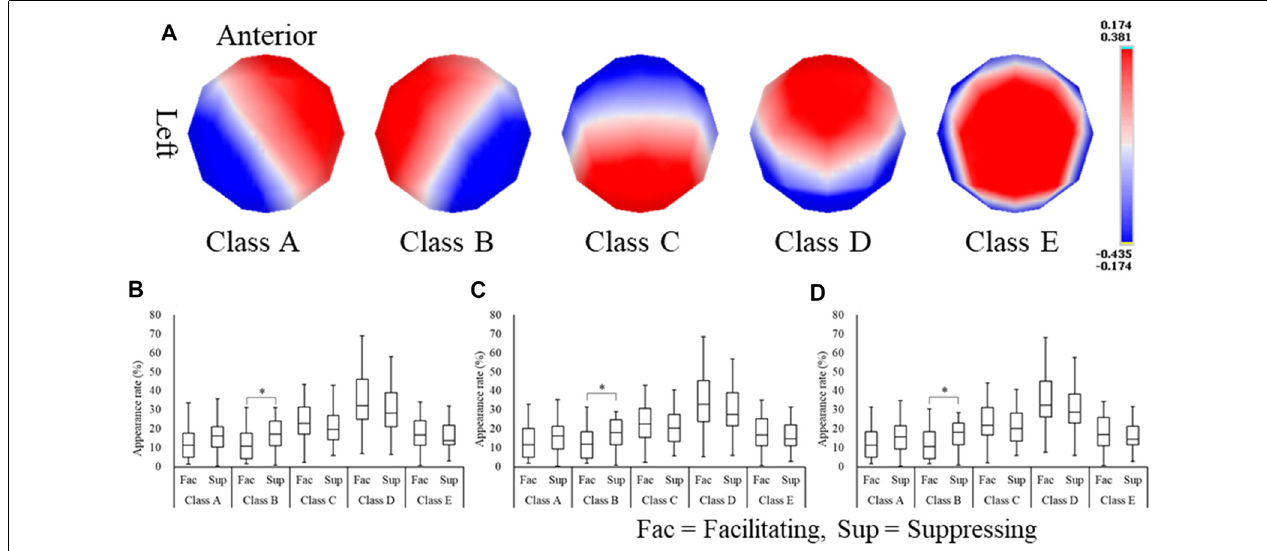
FIGURE 5 | Microstate class maps (A) and the appearance rates of microstate classes for positive (B) , neutral (C) , and negative (D) images. ∗ p <